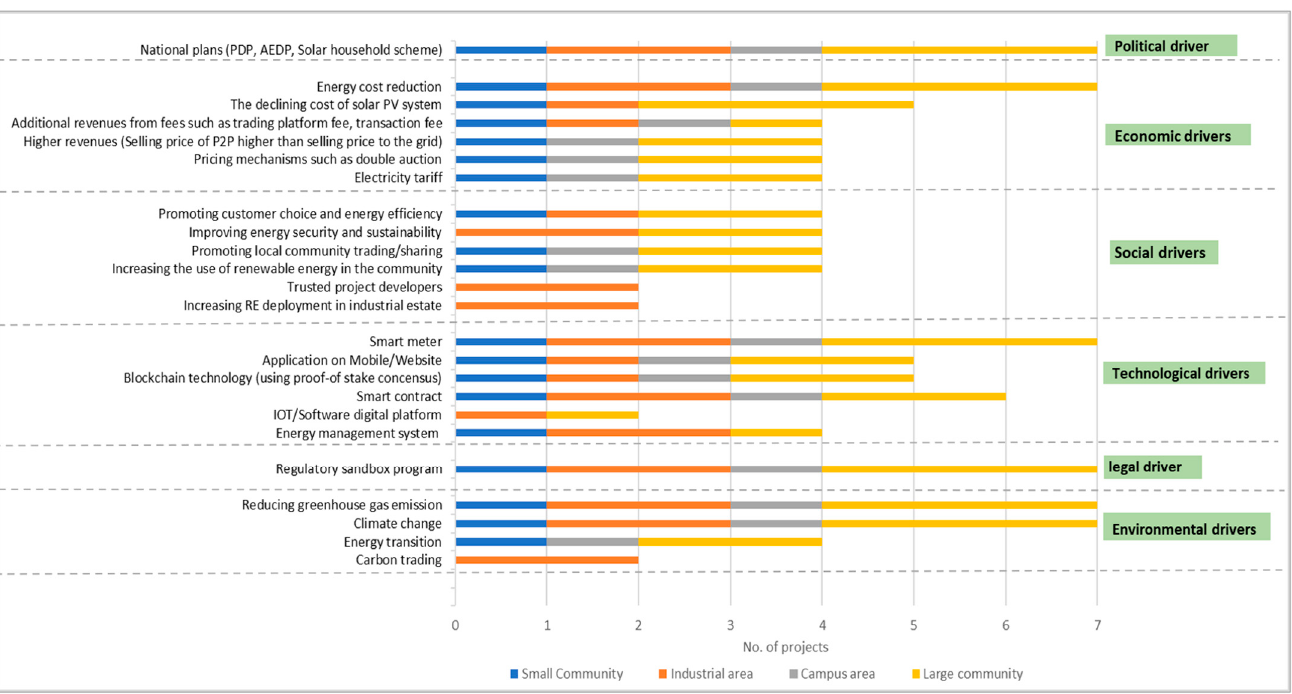
Figure 2. Perceived drivers for P2P energy trading project development under the PESTEL framework.